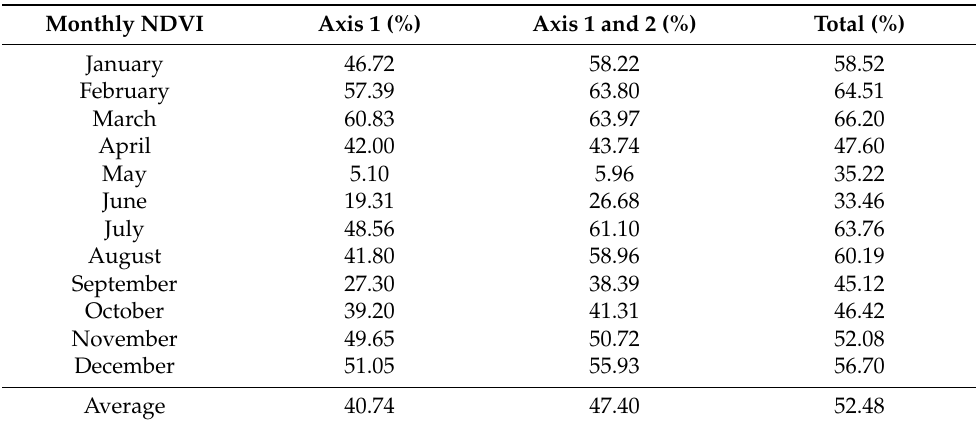
Table 2. Cumulative fraction of variation in individual monthly NDVI explained by the first, the first two, and all RDA axes.